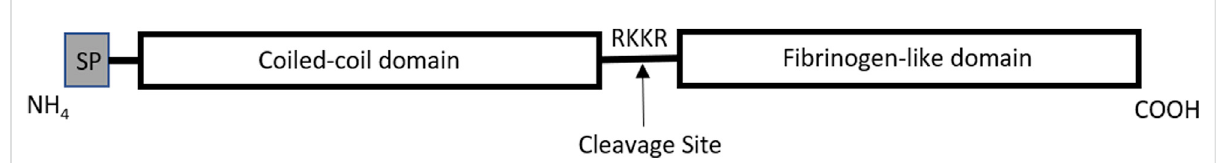
FIGURE 1 Graphic illustration of ANGPTL4 protein domains. The amino terminal region contains a signal peptide (SP) that is removed during posttranslational processing, leaving the coiled-coil and fi brinogen-like domains. Prior to release from intracellular secretory vesicles, ANGPTL4 is cleaved at the RKKR site, creating the NH 4 - and COOH-terminal fragments of ANGPTL4. Illustration adapted from Ko € ster et. al (Köster et al., 2005)